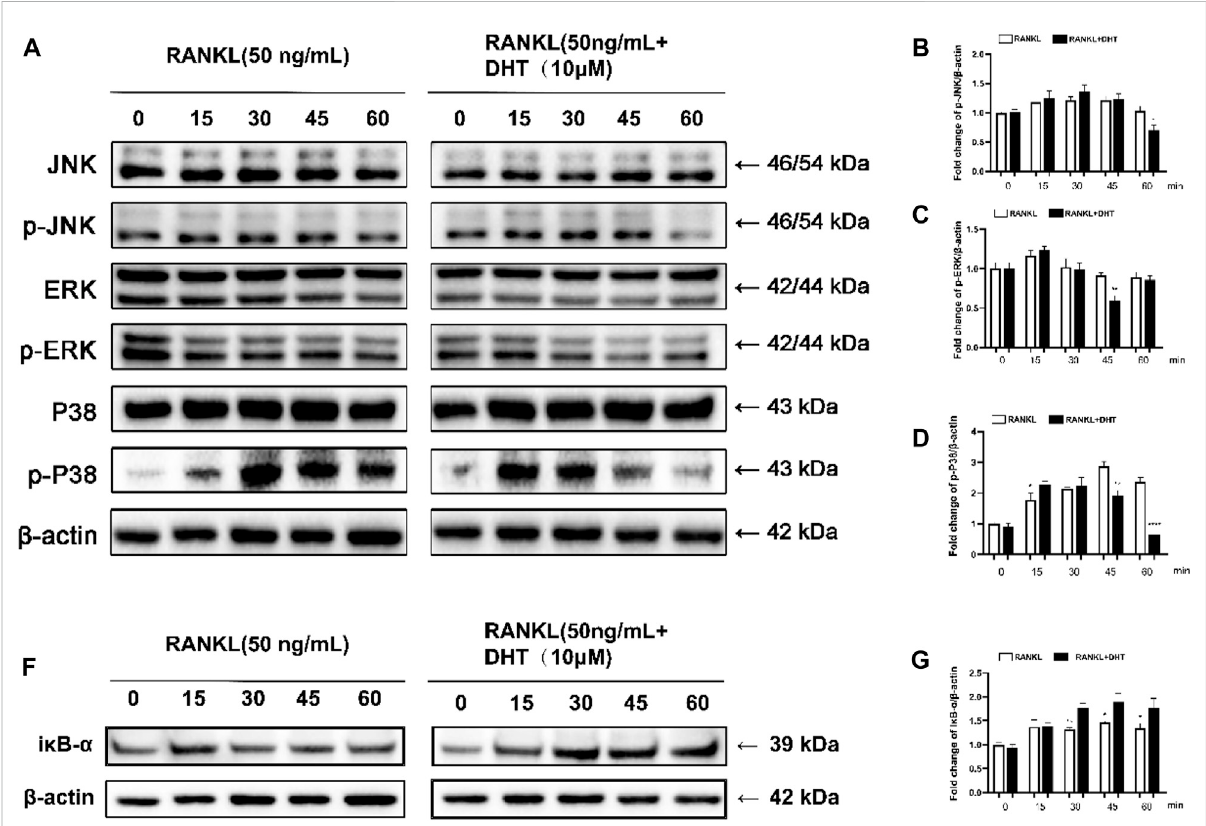
FIGURE 8 DHT inhibits RANKL-induced ERK activation and P38 phosphorylation. (A) p-JNK1/2, JNK, p-ERK1/2, ERK, p-P38, P38, and RANKL were stimulated with DHT dots (with or without 10 μ M) at 0, 15, 30, 45, and 60 min (B – D) Quanti fi cation of the refractive index for the p-ERK, p-P38, and p-JNK bands. (F,G) The relative protein level of I κ B- α is standardized to that of β -actin. ( n = 3). * p < 0.05, ** p < 0.01, *** p < 0.001, **** p < 0.0001 compared to the control